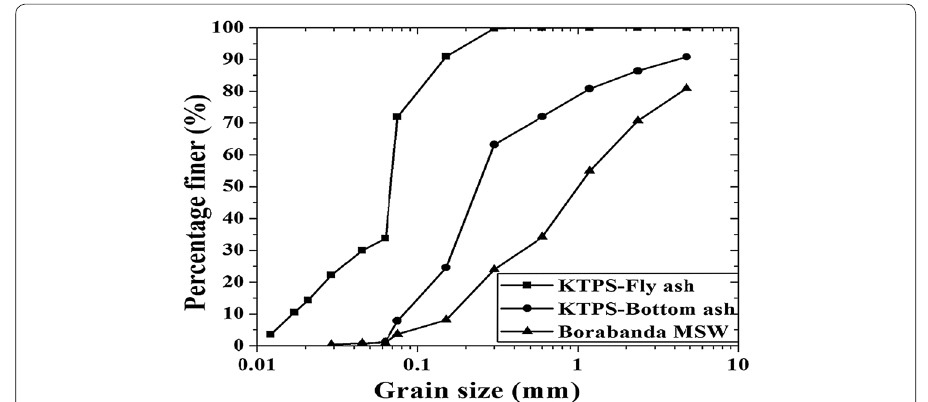
Fig. 13 Grain size distribution curve for KTPS fly ash, KTPS bottom ash and Borabanda MSW